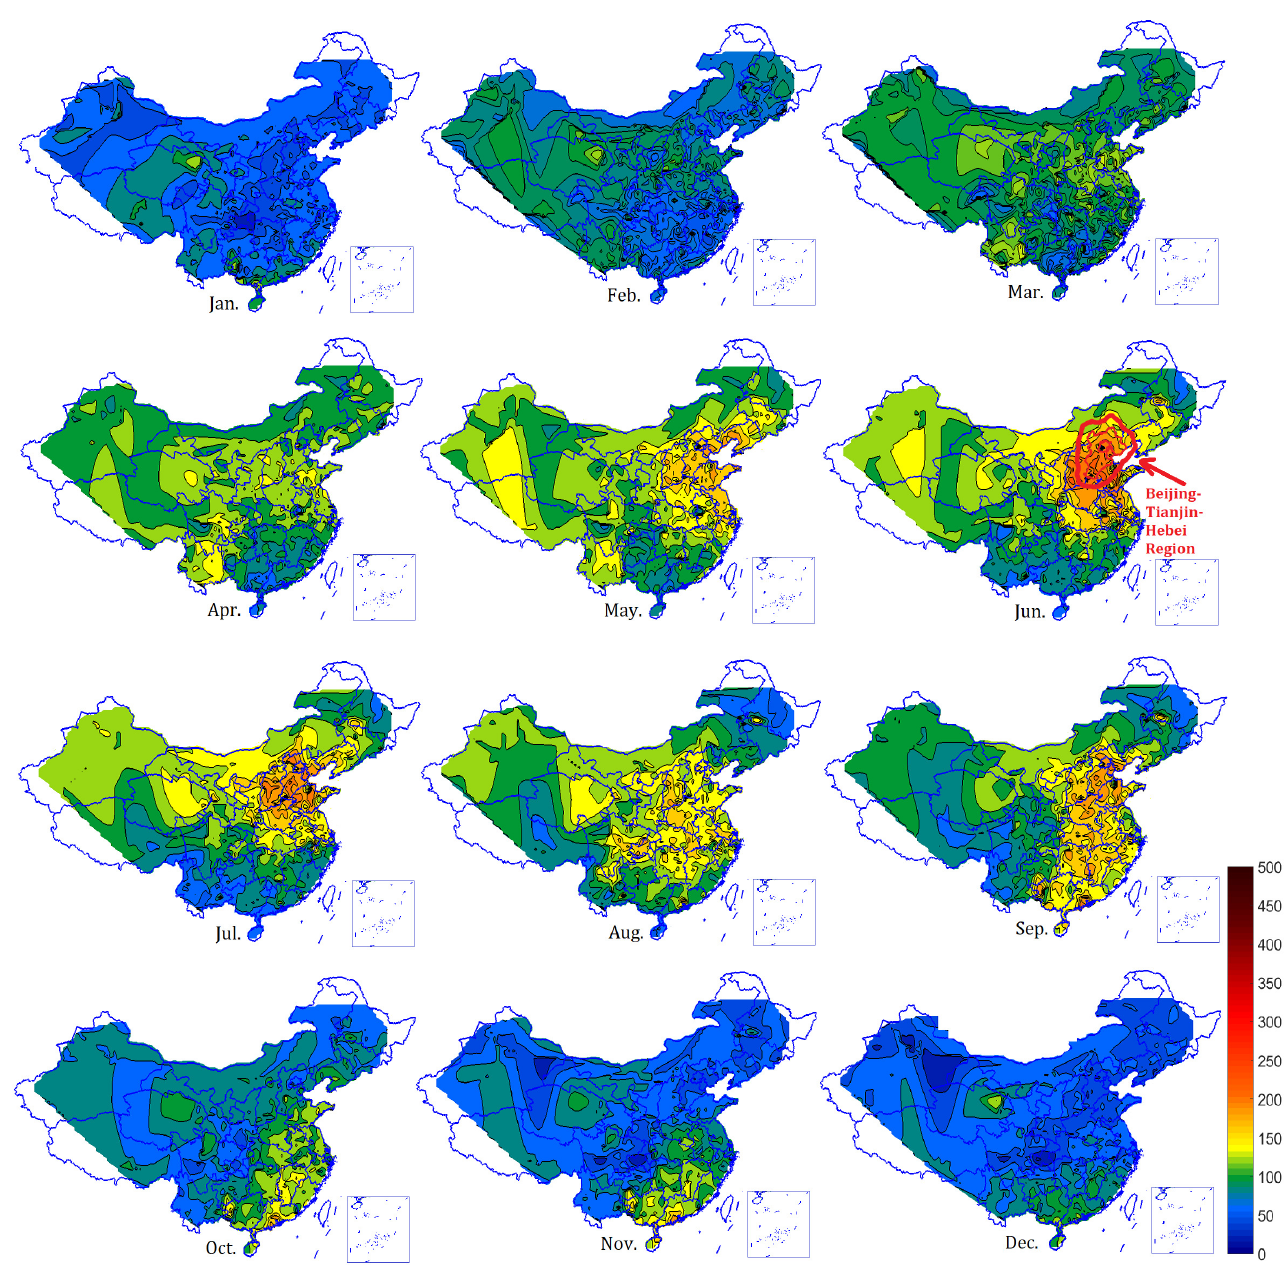
Figure 1. Monthly contour maps of the thresholds (µgm − 3 ) for stations across China in 2019. The boxplots of thresholds among stations in the region were made from April to September in 2015, 2017, and 2019; see Figure 2. The median and mean of the thresholds in each month of 2017 and 2019 were mostly higher than those values in the same month of 2015, showing more severe extreme pollution in 2015. The variances in the thresholds